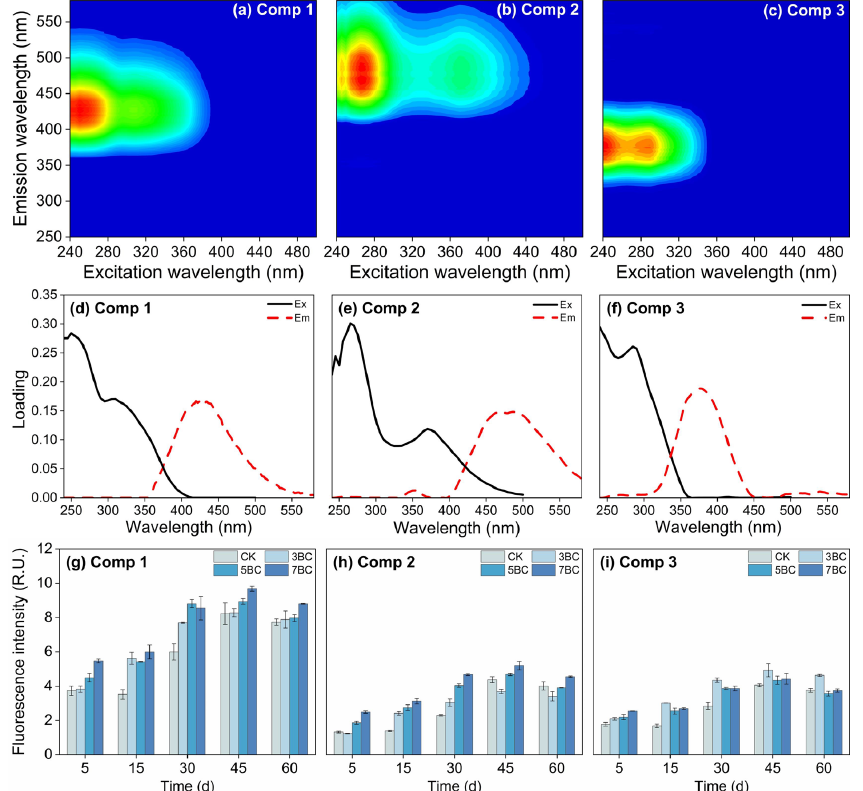
Figure 4. Three fluorescent components (C1: humic-like component enriched with fulvic acids, ( a ); C2: humic-like component, ( b ); C3: protein-like component, ( c )) and corresponding excitation/emission loads ( d – f ) in biochar-treated soils as determined by EEM-PARAFAC analysis, and the fluores- intensity ( g – i ) of the components during incubation. Data are presented as mean ± standard deviation (SD), n = 3. CK, control; 3BC, 300 ◦ C biochar treatment; 5BC, 500 ◦ C biochar treatment; 7BC, 700 ◦ C biochar